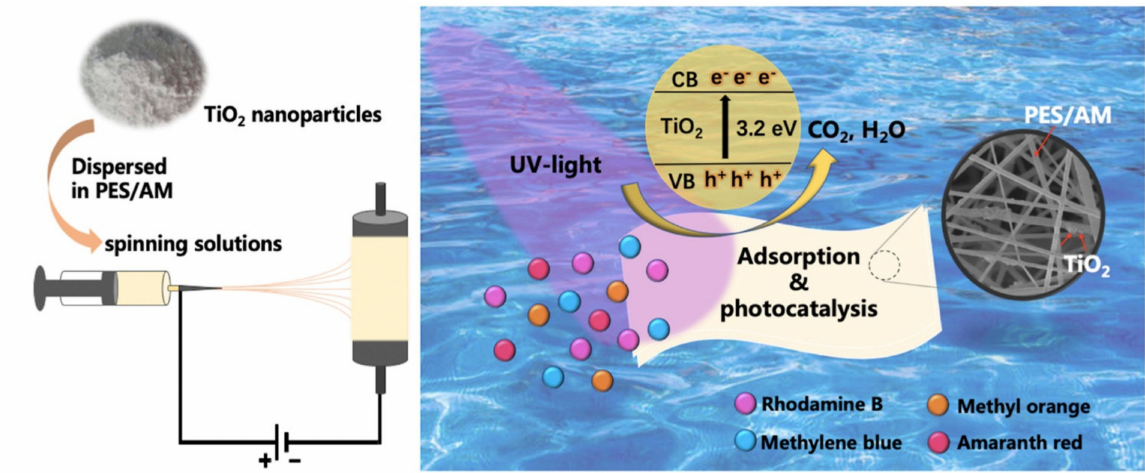
Figure 3. Fabrication of Polyethersulfone (PES)-TiO 2 nanofiber composite membrane via electrospinning as well as simultaneous adsorption and photodegradation of micropollutants. Reprinted from [44] with permission from